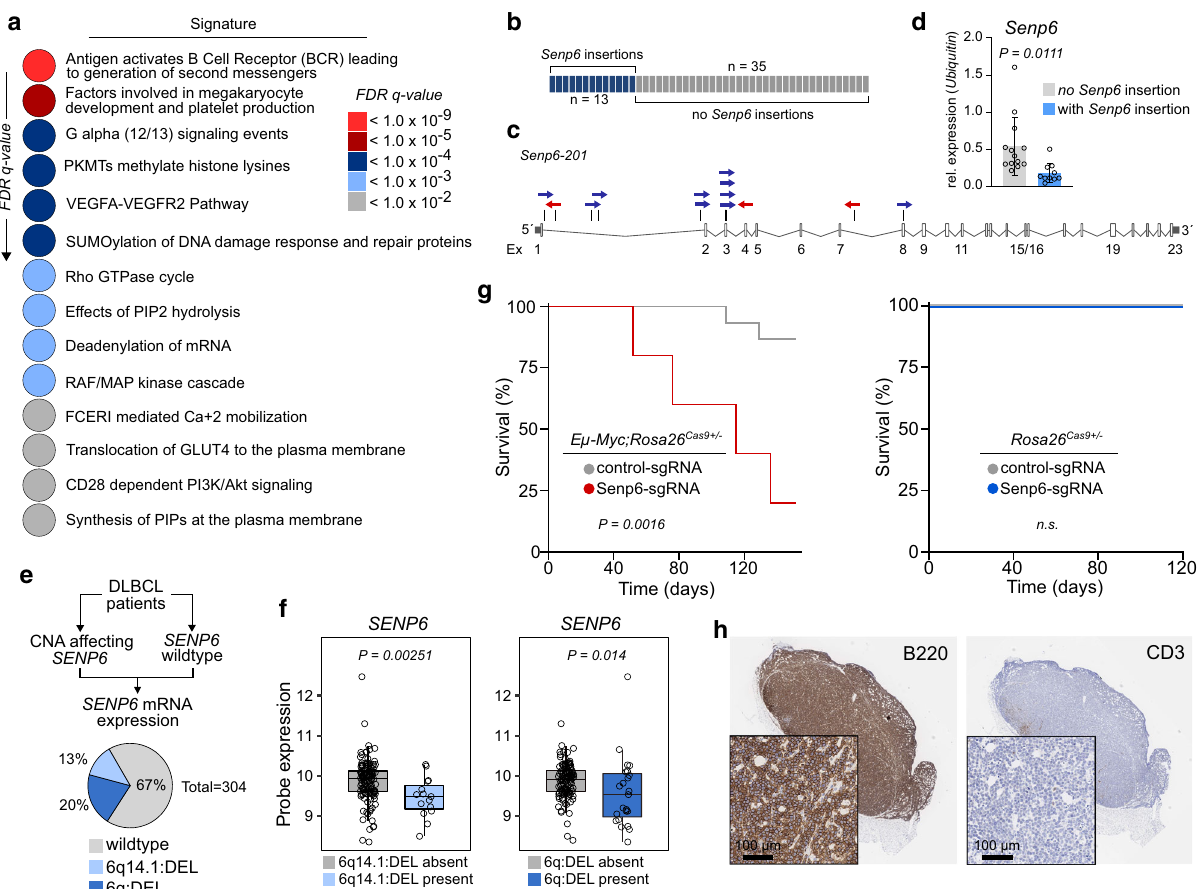
Fig. 2 SENP6 is a tumor suppressor of B-cell lymphomagenesis and is recurrently deleted in human DLBCL. a E µ -myc CISs were analyzed using the Reactome database. Color-coded FDR q-value is shown for the top fourteen pathways. b Schematic depiction of A/R/M lymphomas with Senp6 transposon insertion and without Senp6 transposon insertion. c Transposon insertion pattern in Senp6 indicates tumor suppressor function and the number of affected tumors. Only the dominant insertion per tumor is shown. d Senp6 expression in A/R/M lymphomas with Senp6 transposon insertions ( n = 10) and A/R/M lymphomas without Senp6 transposon insertion ( n = 13). Senp6 expression was normalized to Ubiquitin . Data are presented as mean ± SD. P -value determined by unpaired t -test (two-tailed). e Copy number alterations (CNA) affecting SENP6 in human DLBCL ( n = 304). Wildtype , n = 205; 6q14.1:DEL, n = 38; 6q:DEL, n = 61. f SENP6 mRNA levels in DLBCL groups according to their SENP6 copy number status. 6q14.1:DEL absent, n = 122; 6q14.1:DEL present, n = 15; 6q:DEL absent, n = 114; 6q:DEL present, n = 23. The centerline of the box plot is the median. The box extends from the 25th to 75th percentiles. Whisker length is from minimum to maximum. P-value determined by Wilcoxon Rank Sum Test (two-sided). g Left panel: Kaplan – Meier survival curves of mice transplanted with E µ -myc;Rosa26 Cas9 HSPCs transduced with sgRNAs targeting Senp6 . Senp6 , n = 5; control n = 15; p = 0.0016. P-value determined by log-rank (Mantel – Cox) test. Right panel: Kaplan – Meier survival curves of mice transplanted with Rosa26 Cas9 HSPCs transduced with sgRNAs targeting Senp6 . Senp6 , n = 6; control n = 5. h Representative histological and immunohistochemical analysis of one of three analyzed E µ -myc;Rosa26 ; Cas9 Senp6-sgRNA HSPC-derived lymphomas for B220 and CD3 expression. The analysis was repeated three times for each cohort with similar follicular (15.6%), and Burkitt lymphoma (6.5%), indicating a associated loss of SENP6 protein in Senp6- sgRNA lymphomas possible role of SENP6 or the SUMOylation pathway in other (Supplementary Fig. 3f, g). Importantly, depletion of SENP6 did lymphomas (Supplementary Fig. 3d). Finally, to prove a not promote tumorigenesis in Rosa26 Cas9 control FL-HSPCs recipients (Fig. 2g, right panel), indicating that a co-driver such as functional role for SENP6 loss in an established model of B-cell MYC is needed for SENP6 loss to promote tumorigenesis. Thus, lymphomagenesis in vivo, we generated hematopoietic stem cell this in vivo experiment proved that loss of Senp6 accelerated grafts from Eµ-myc;Rosa26 Cas9 mice. E13.5 fetal liver-derived hematopoietic stem and progenitor cells (FL-HSPC) were MYC-driven B-cell lymphomagenesis in mice, providing direct transduced with lentivirus encoding a sgRNA targeting Senp6 experimental evidence that deregulated SUMO deconjugation (Supplementary Fig. 3e). Transduction ef fi ciency was between 20 accelerates cancer formation. and 30% as assessed by the GFP reporter. Syngeneic wild-type To gain insight into the associated mechanisms, we mice receiving Senp6 sgRNA FL-HSPC grafts were monitored for searched the Cancer Cell Line Encyclopedia (https://portals. lymphoma onset. Loss of Senp6 signi fi cantly promoted B-cell lymphomagenesis in vivo (Fig. 2g, left panel and Fig. 2h), DHL-5, OCI-Ly19) and without (SU-DHL-6, OCI-Ly1) genomic validating the fi ndings from the PB screen for this speci fi c gene. SENP6 loss (Fig. 3a, upper panel). Next, we reconstituted SENP6 As expected, we detected insertions and deletions (InDels) with expression in SENP6 -deleted SU-DHL-5 cells and analyzed the